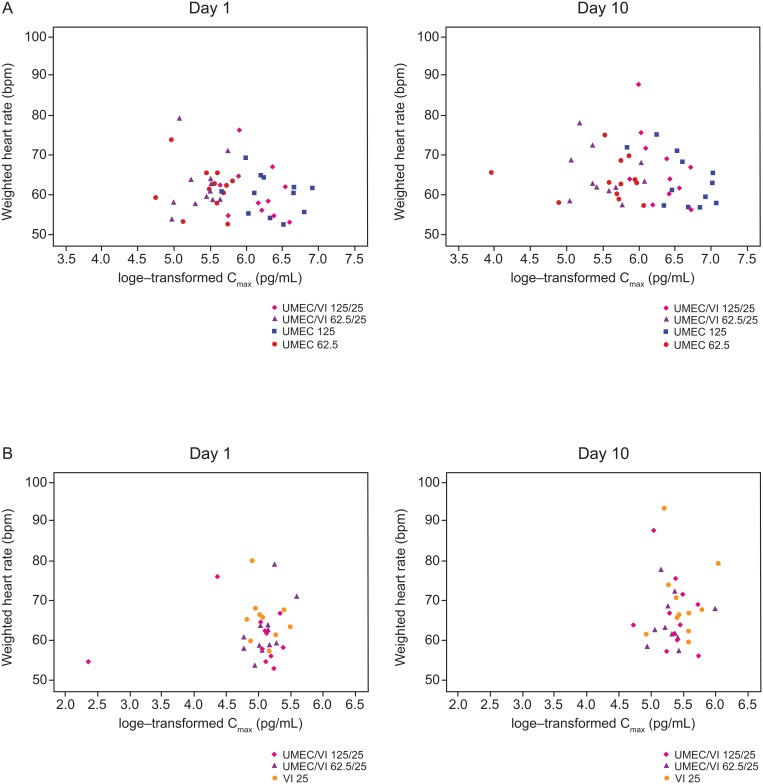
Loge-transformed Cmax against weighted mean heart rate (0–4 h) for UMEC (A) and VI (B).bpm, beats per minute; Cmax, maximum plasma concentration; PK, pharmacokinetic; UMEC, umeclidinium; VI, vilanterol.